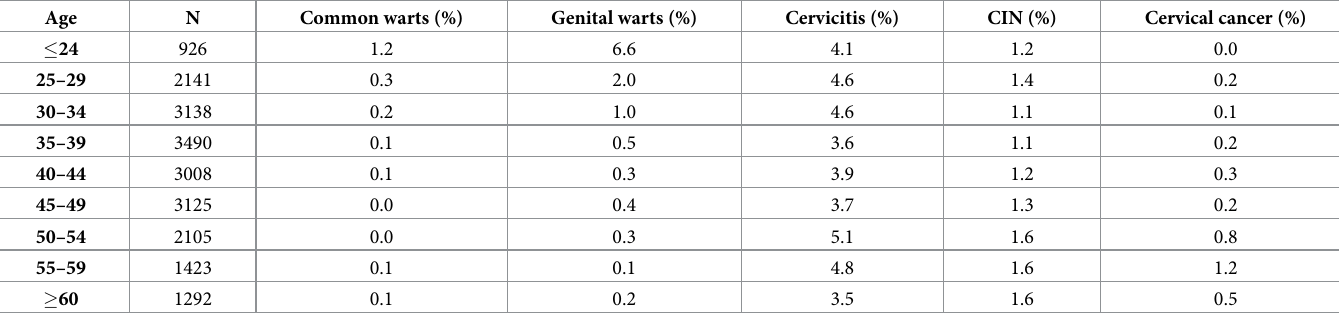
Table 3. Overall age-related morbidity among